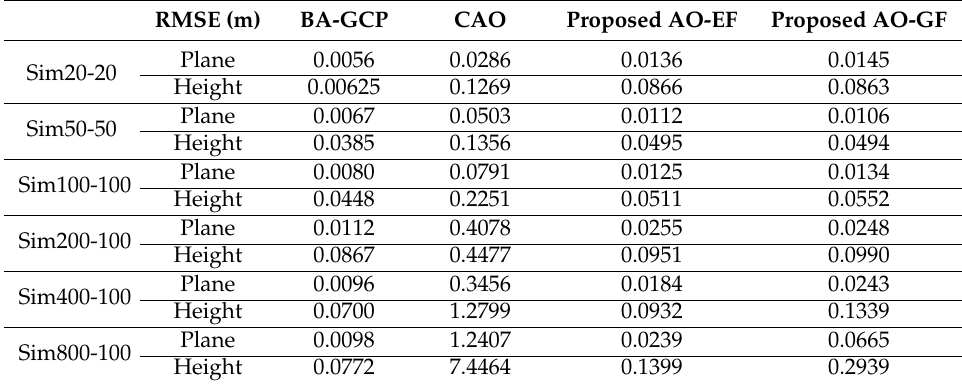
Table 2. The plane and height RMSE obtained using the classical method and the proposed method. CAO, classical absolute orientation; AO-EF, absolute orientation with the exponential kernel function; GF, Gaussian kernel function. RMSE (m) BA-GCP